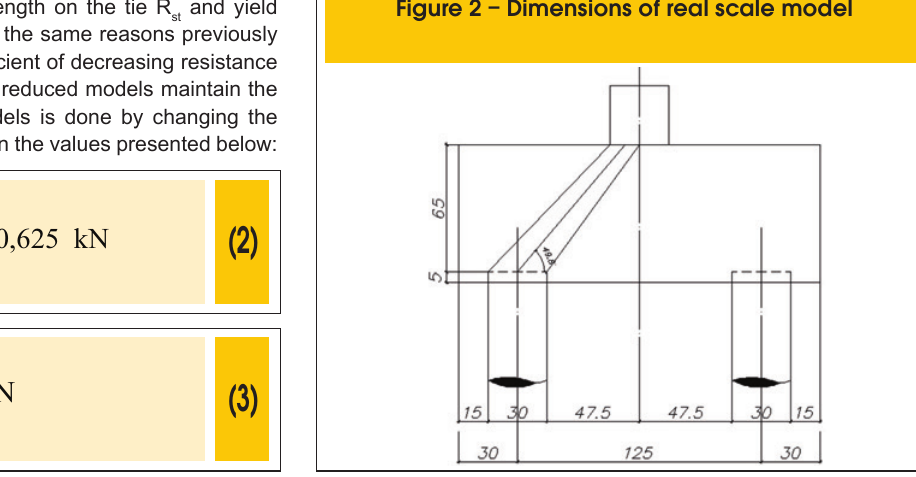
Figure 2 – Dimensions of real scale